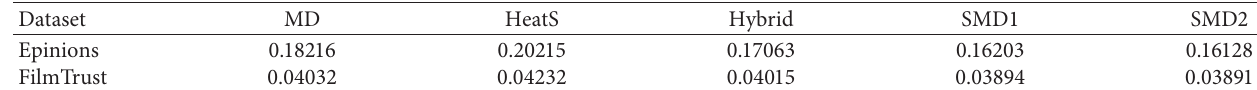
Figure 6: The simulation results of SMD2. (a) Epinions dataset. (b) FilmTrust dataset. Table 1: The results of the contrastive